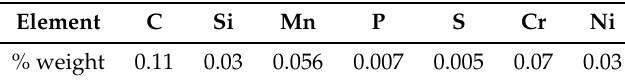
Table 1. Chemical composition of S235JR